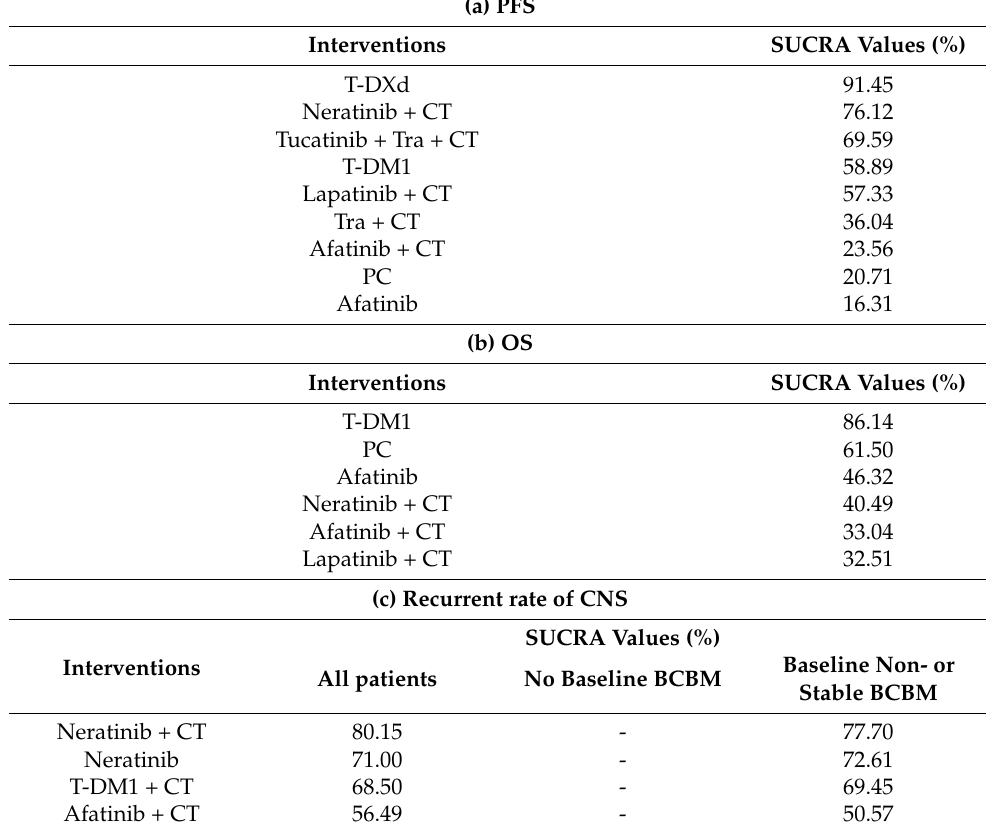
Table 4. SUCRA values for different interventions of PFS ( a ), OS ( b ) and the recurrent rate of CNS ( c